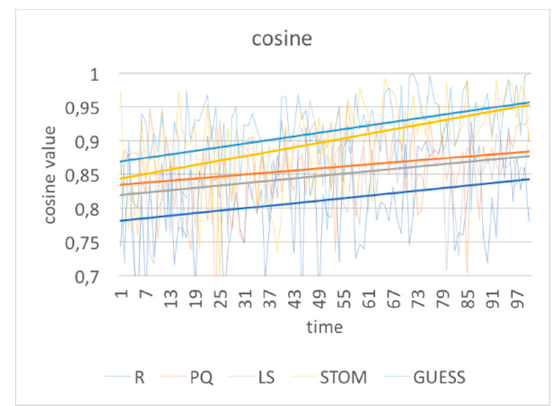
Figure 5. Cumulative reward over time for f (3) . Appl. Sci. 2018 , 8 , 136 12 of 20